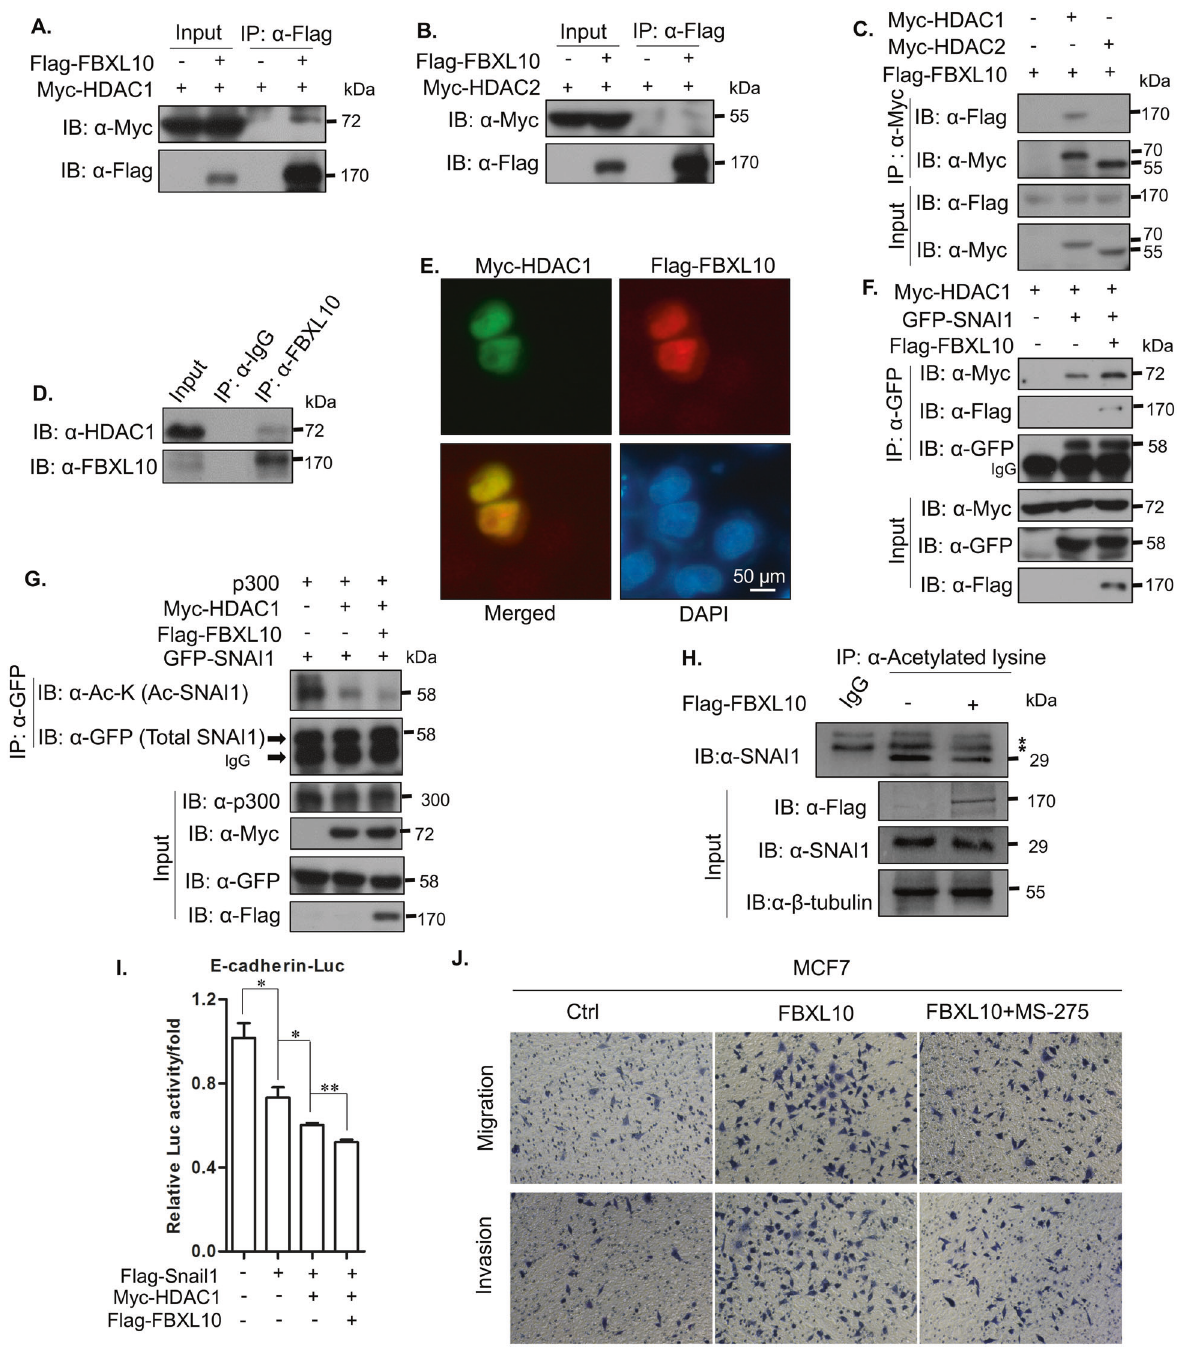
Fig. 6 FBXL10 enhanced the interaction between SNAI1 with HDAC1 and facilitated HDAC1-mediated deacetylation of SNAI1. A – C CoIP assay showed the association between exogenous FBXL10 with HDAC1 and HDAC2. D CoIP assay showed the endogenous protein interaction between FBXL10 and HDAC1. E . Immuno fl uorescence assay showed the colocalization of FBXL10 (red) and HDAC1 (green) in MCF7 cells. F CoIP assay showed the effect of FBXL10 overexpression on the interaction between SNAI1 and HDAC1. G CoIP assay showed the effect of FBXL10 on HDAC1-mediated deacetylation of exogenous SNAI1. H CoIP assay showed the effect of overexpression FBXL10 on endogenous SNAI1 acetylation. I Reporter gene assay assessed the effect of FBXL10/SNAI1/HDAC1 on the E-cadherin luciferase activity. J Transwell assay was performed to evaluate the effect of FBXL10 and HDAC1 inhibitor MS-275(1 μ M for 12 h) on the migration and invasion of MCF7